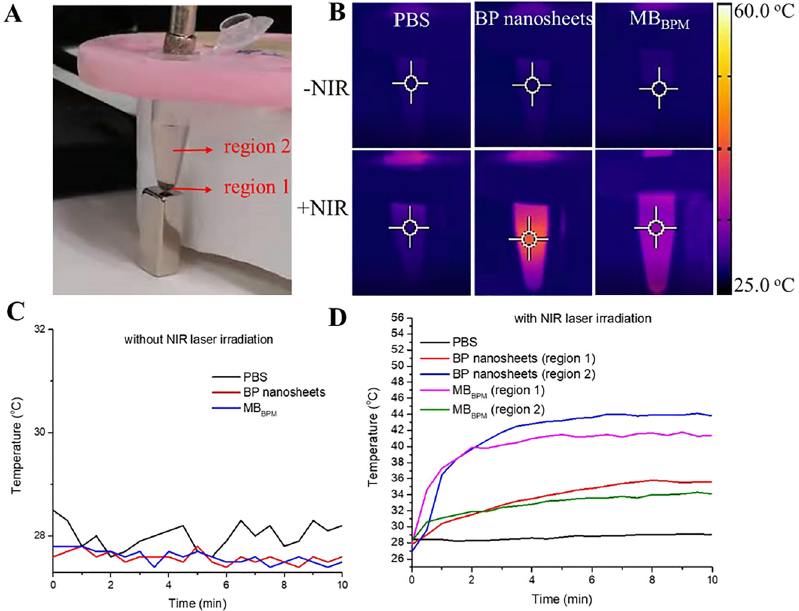
Figure 8: (A) The measurement schematic